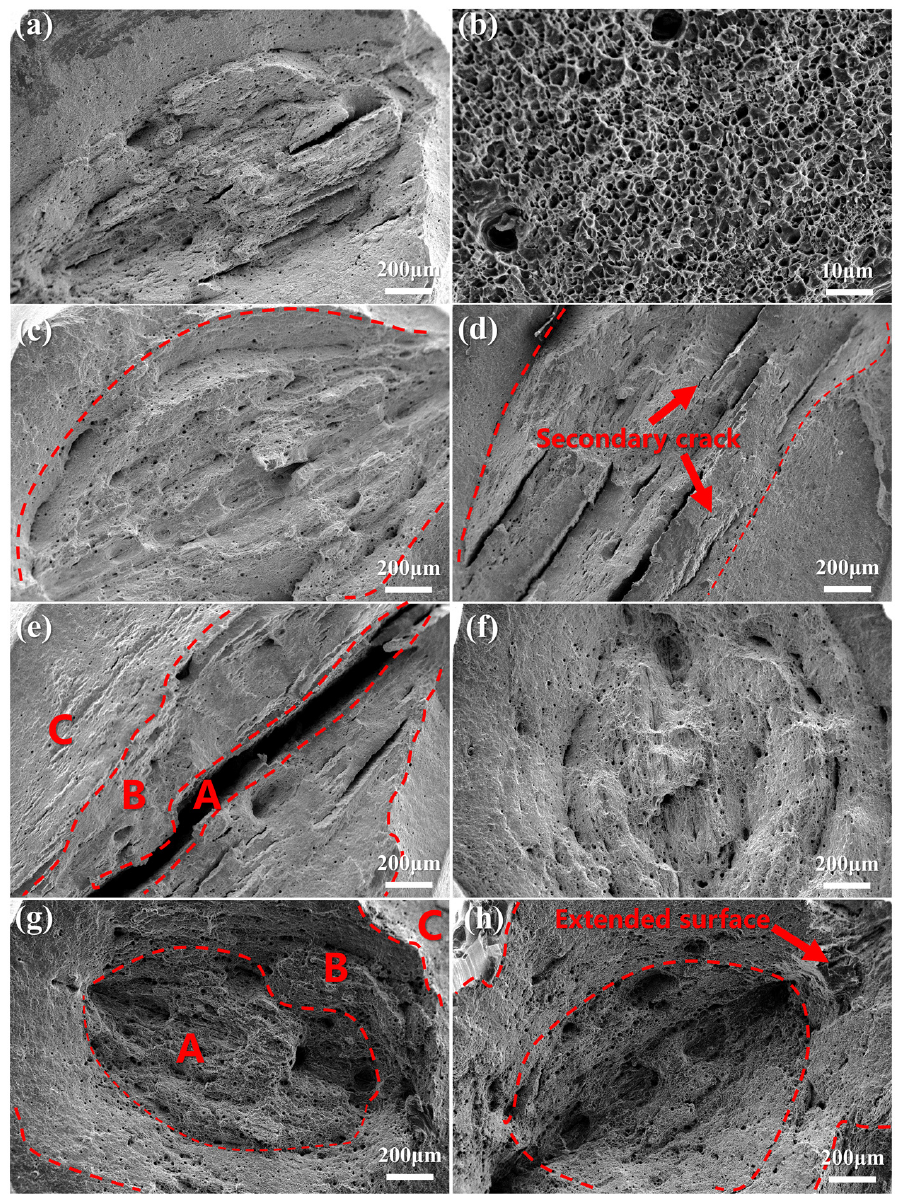
Figure 10. Thermal simulation of tensile fractures at different t 8/5 values: ( a ) BM, ( b ) microporous structure of BM, ( c ) t 8/5 = 4 s, ( d ) t 8/5 = 6 s, ( e ) t 8/5 = 8 s, ( f ) t 8/5 = 10 s, ( g ) t 8/5 = 14 s, and ( h ) t 8/5 = 18 s.